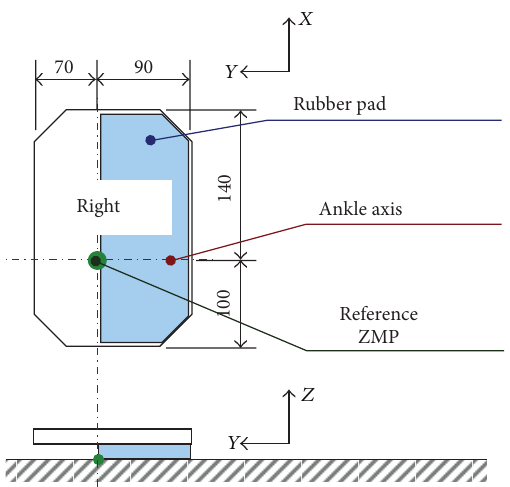
Figure 6: Narrow feet with 90 mm breadth. A rubber pad with 90 mm breadth is attached to the sole of the robot’s feet.